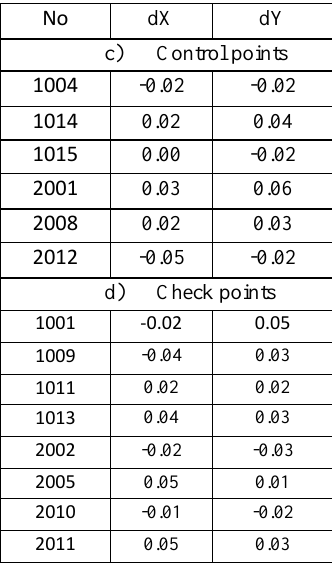
Table 3. Deviation measured on orthomaps and in terrain by GPS technology, on selected points for the UAV